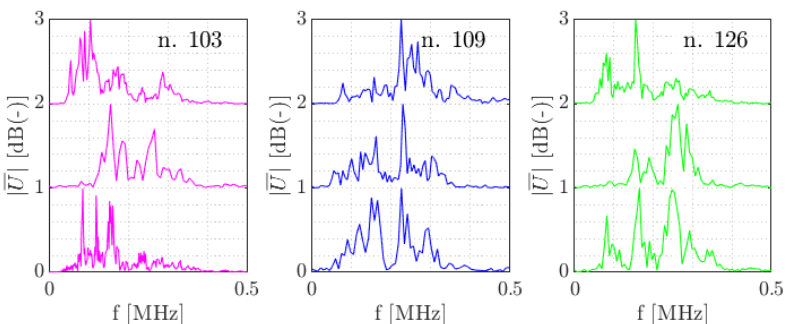
Figure 17. Normalised amplitude spectra belonging to the waveforms from Figure 16.